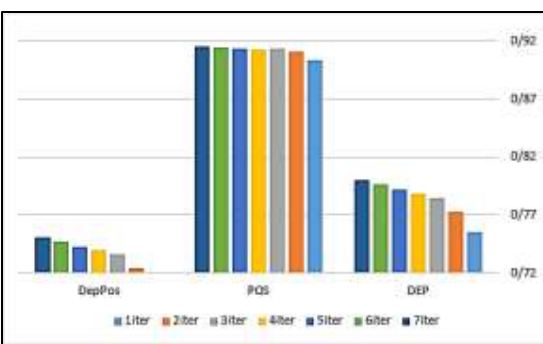
Figure 6. Study of relationship between iteration on